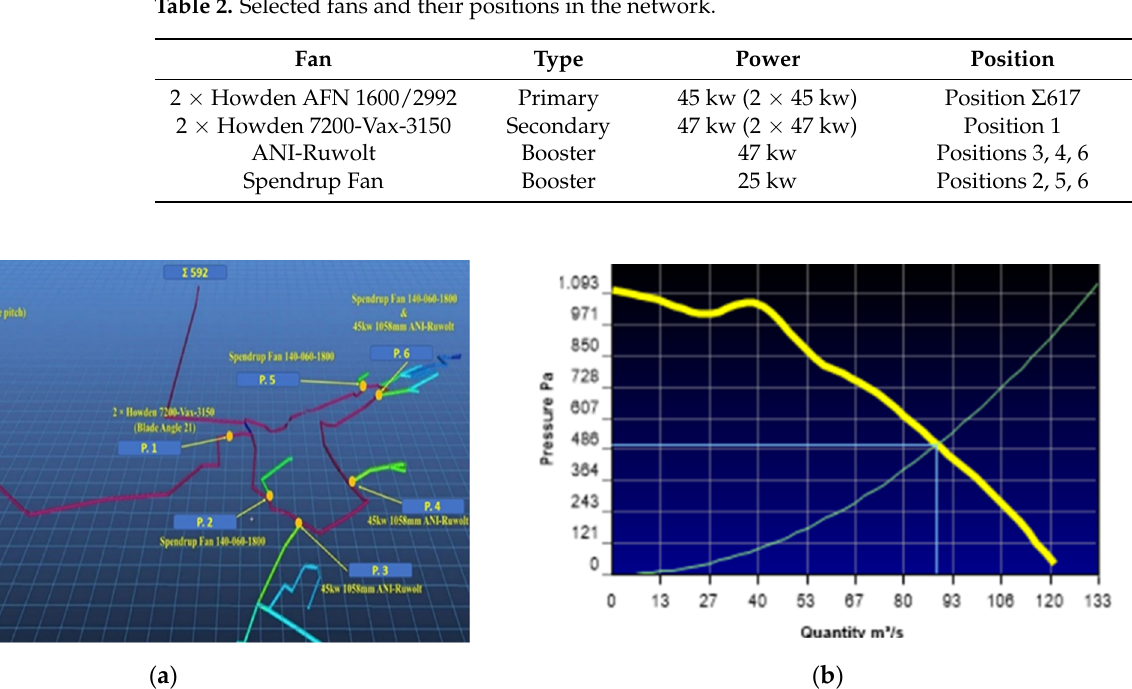
Figure 2. ( a ) Overview of the 3D ventilation model that was developed in Ventsim Design. ( b ) Operating point of ventilation system.